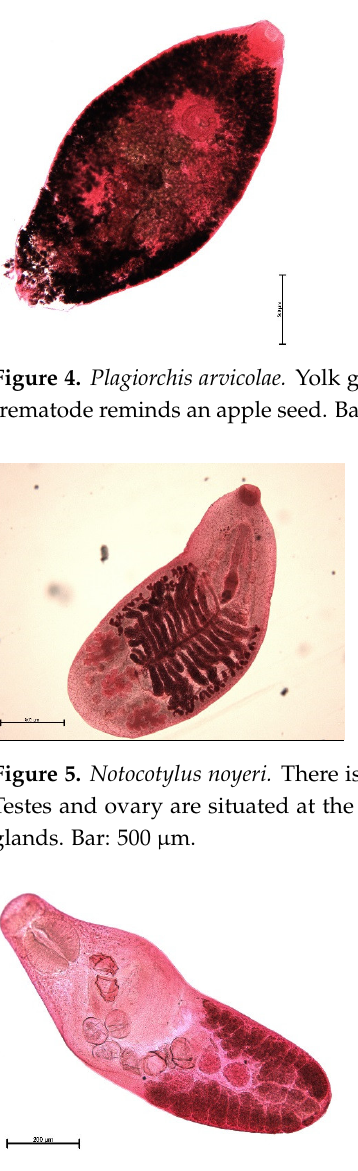
Figure 6. Psilosostoma simillimum. Pharynx and ventral sucker are strikingly larger than oral sucker. Bar: 200 µ m.